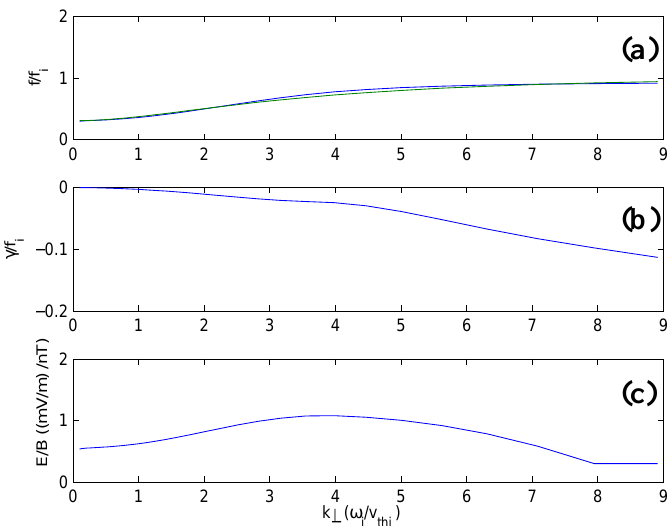
Fig. 8. Solutions from WHAMP code. (a) shows the real frequency of a kinetic Alfv`en wave with k k =0.1 normalized to ion cyclotron frequency at B =85nT as a function of k ⊥ (blue). The green line in (a) shows the solution of the real frequency calculated from the dispersion relation of kinetic Alfv´en (Eq. 2) waves normalized to WHAMP units. (b) Damping (imaginary frequency) as a function of k ⊥ . (c) E ⊥ / B ⊥